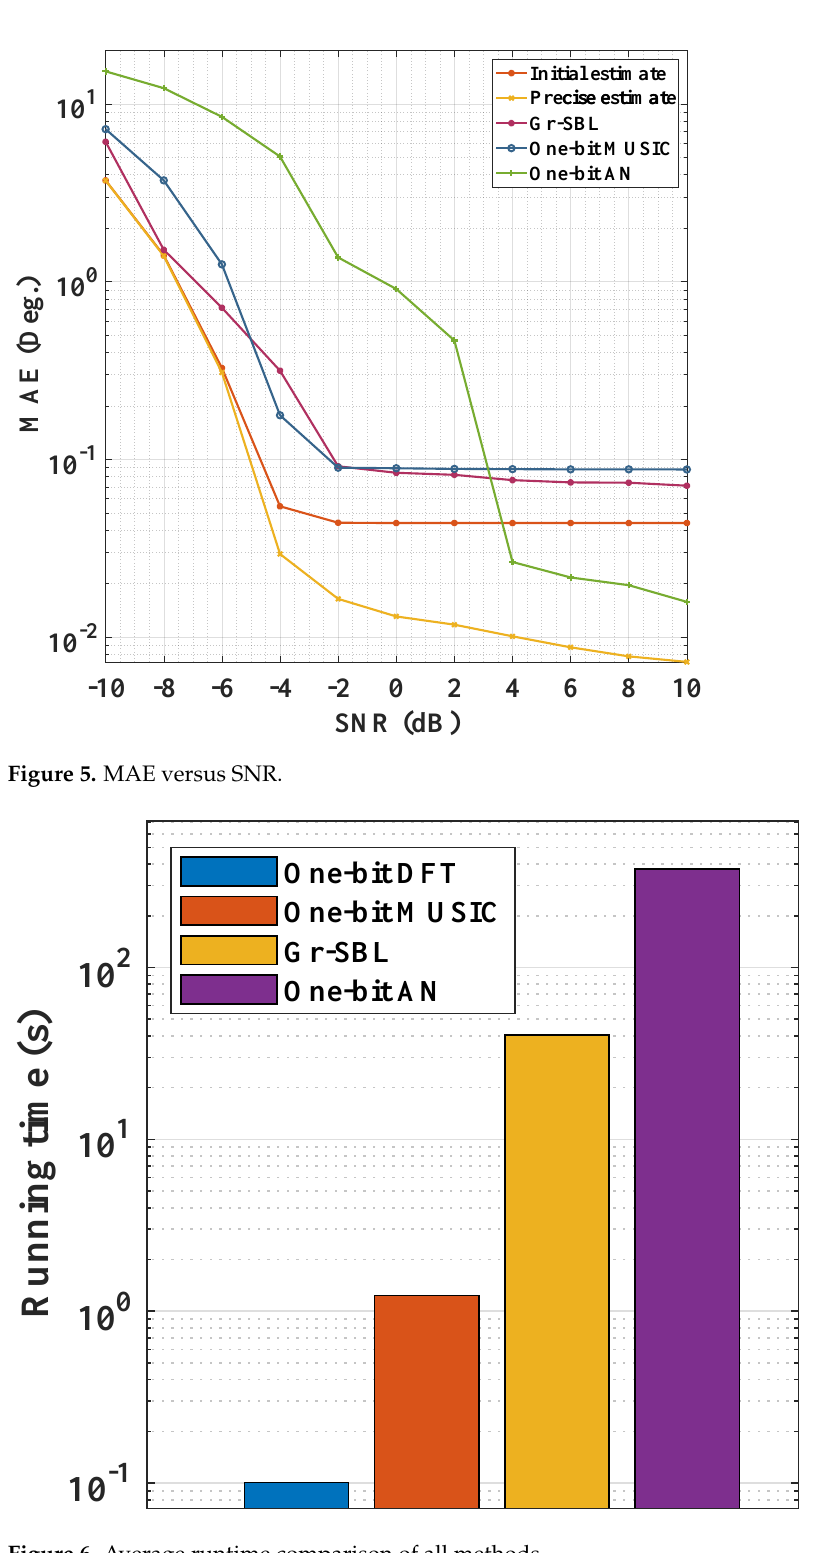
Figure 6. Average runtime comparison of all methods. In the third simulation, the effect of snapshot number on the performance of the proposed method is evaluated. Figure 7 depicts the MAE versus SNR curve of the proposed method for varying numbers of snapshots, where M = 500 and N = 200. It can be observed that, as the number of snapshots increases, the accuracy of the proposed method’s precise estimation